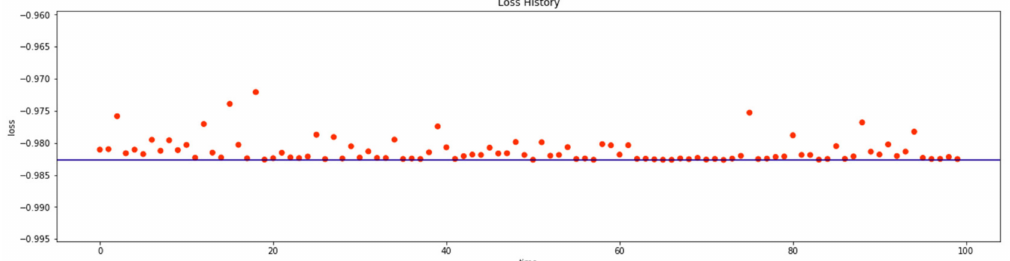
Figure 8. Loss-time graph with a best average error of gradient boosting machine of − 0.9826 and a finite loss range of − 0.9827, − 0.9720, and −